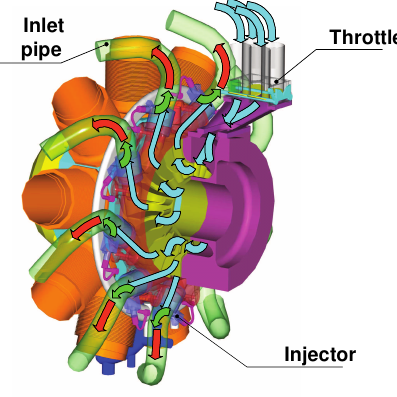
Fig. 1. ASz-62IR supplied by injection system